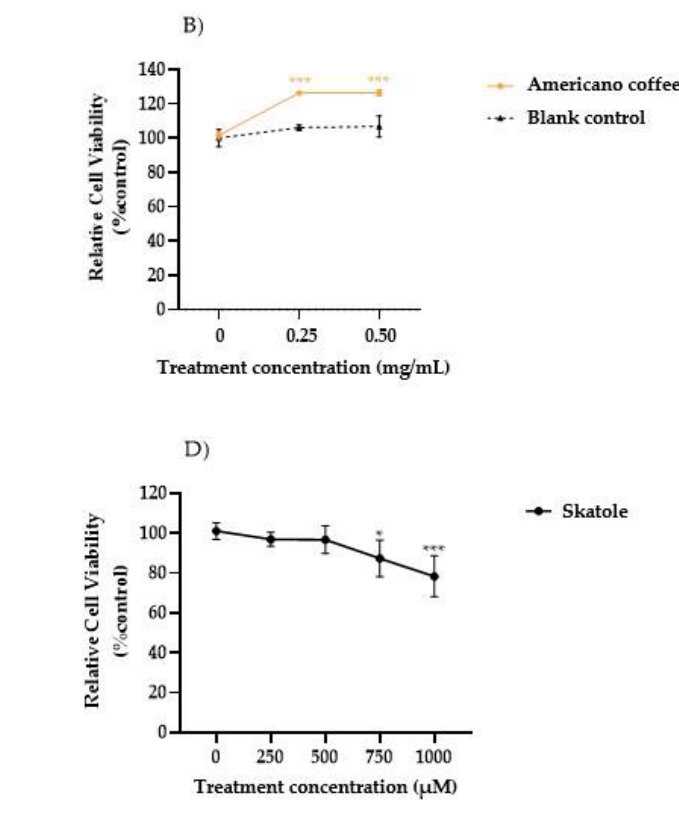
Figure 1. Evaluation of cell viability in HT-29 cells. The effect of treatment with different types of coffee extract: instant ( A ), Americano ( B ), and espresso ( C ), at 0.250 and 0.500 mg/mL on cell viability was evaluated using the MTT assay after 24 h with respect to the mock control. The MTT test was used to determine the impact of skatole treatment ( D ) on cell viability after 24 h at the concentrations of 250, 500, 750, and 1000 µM compared with control cells (treated only with DMSO). The graph represented the mean and SD of three separate experiments. * p -value ≤ 0.05 and *** p -value ≤ 0.001 compared to the control group (calculated as fold-change relative to control cells, arbitrarily set at 100%).